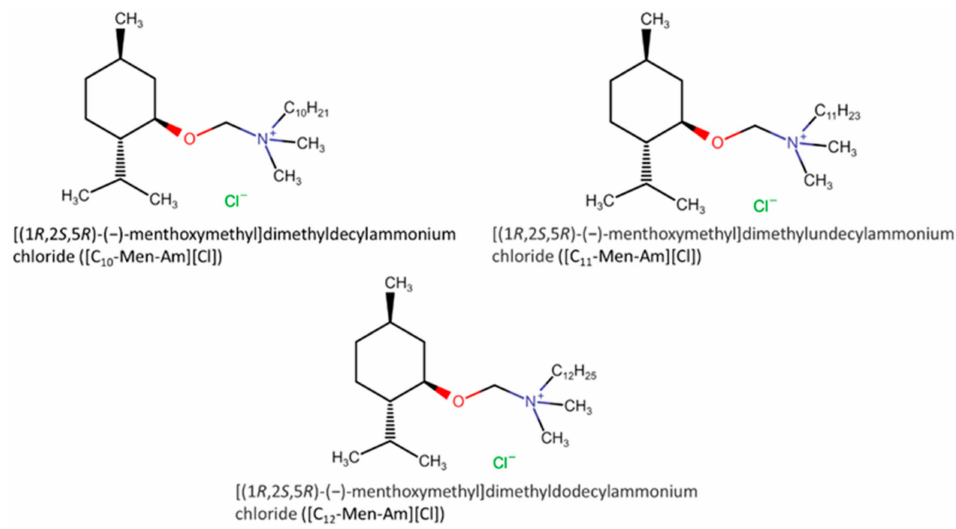
Figure 4. Structures of alkyl[(1R,2S,5R)-( − )-menthoxymethyl] dimethylammonium chloride